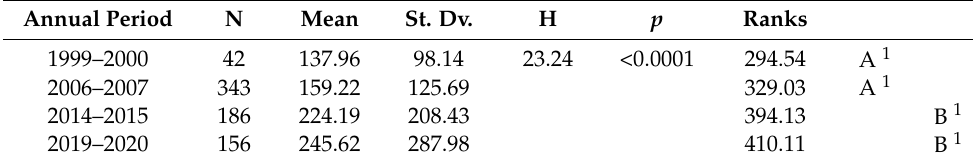
Table A9. Euclidean Distance’s Kruskal Wallis tests between time periods for the Ituzaing ó